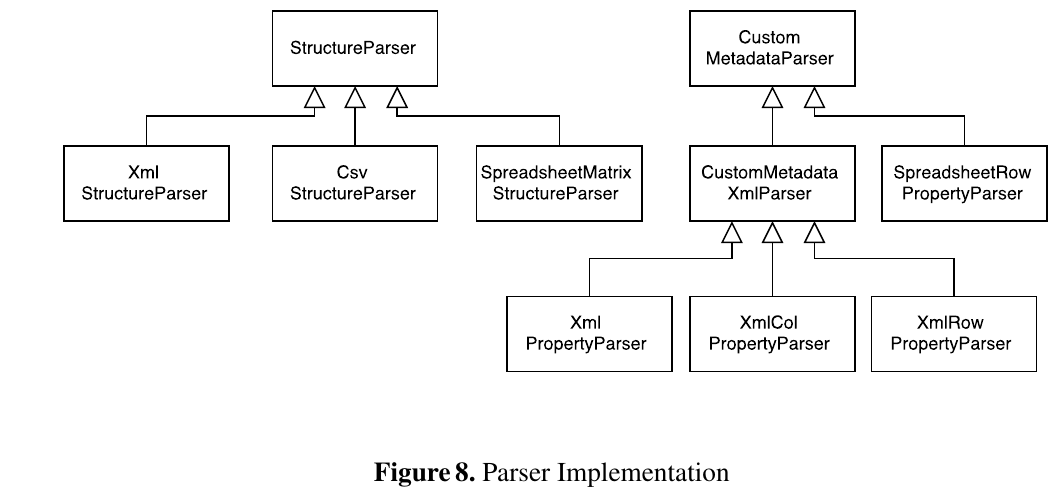
Figure 8. Parser